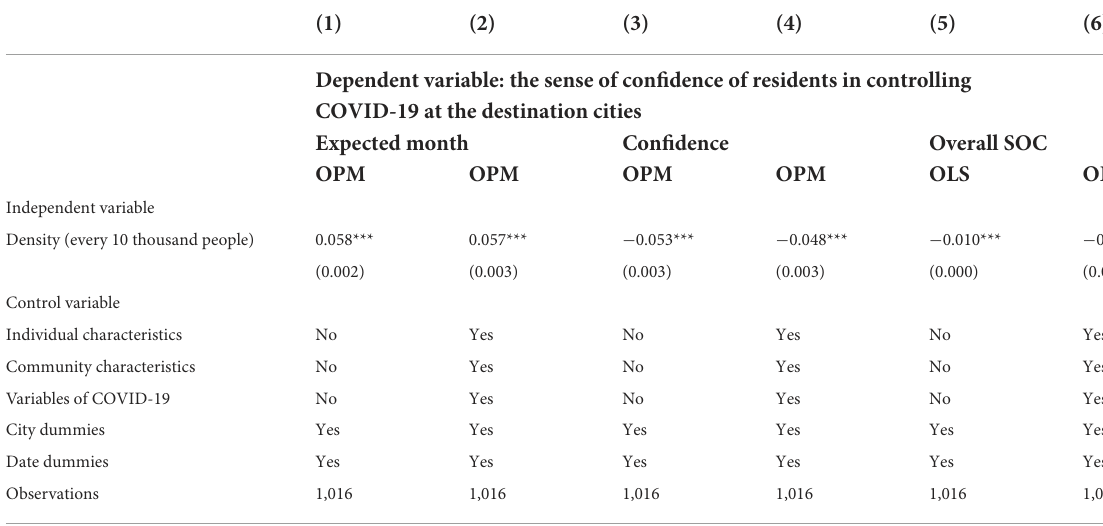
TABLE 7 Replacement of the independent variable with